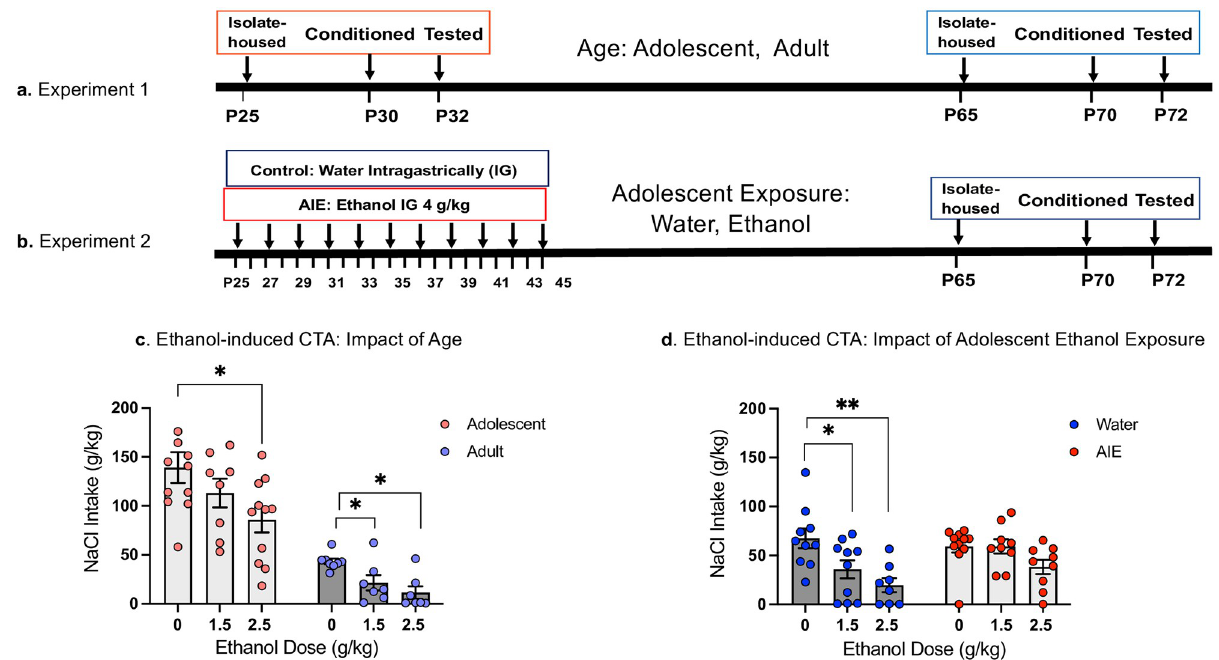
Fig 1. Timelines and NaCl (CS) intake on test day in Experiment 1 and Experiment 2. Timelines for Experiments 1 and 2, respectively (a, b), and NaCl (CS) intake (g/kg) on test day (c, d, respectively) are shown. Asterisks depict significant changes in NaCl intake on test day within each Age relative to controls conditioned with saline (0 g/kg EtOH dose), � —p < 0.05, �� —p < 0.01.